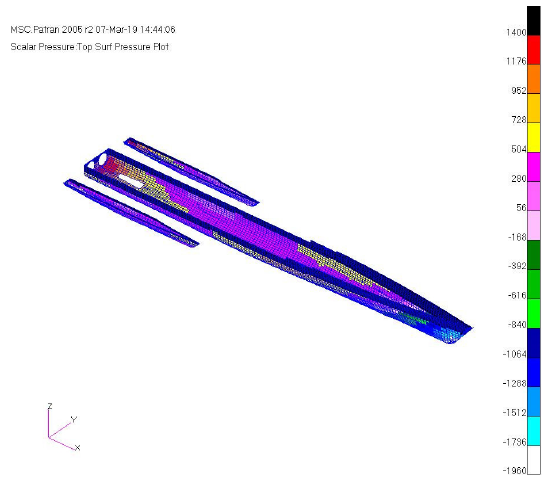
Figure 2. The hydrodynamic pressure on trimaran’s surface.